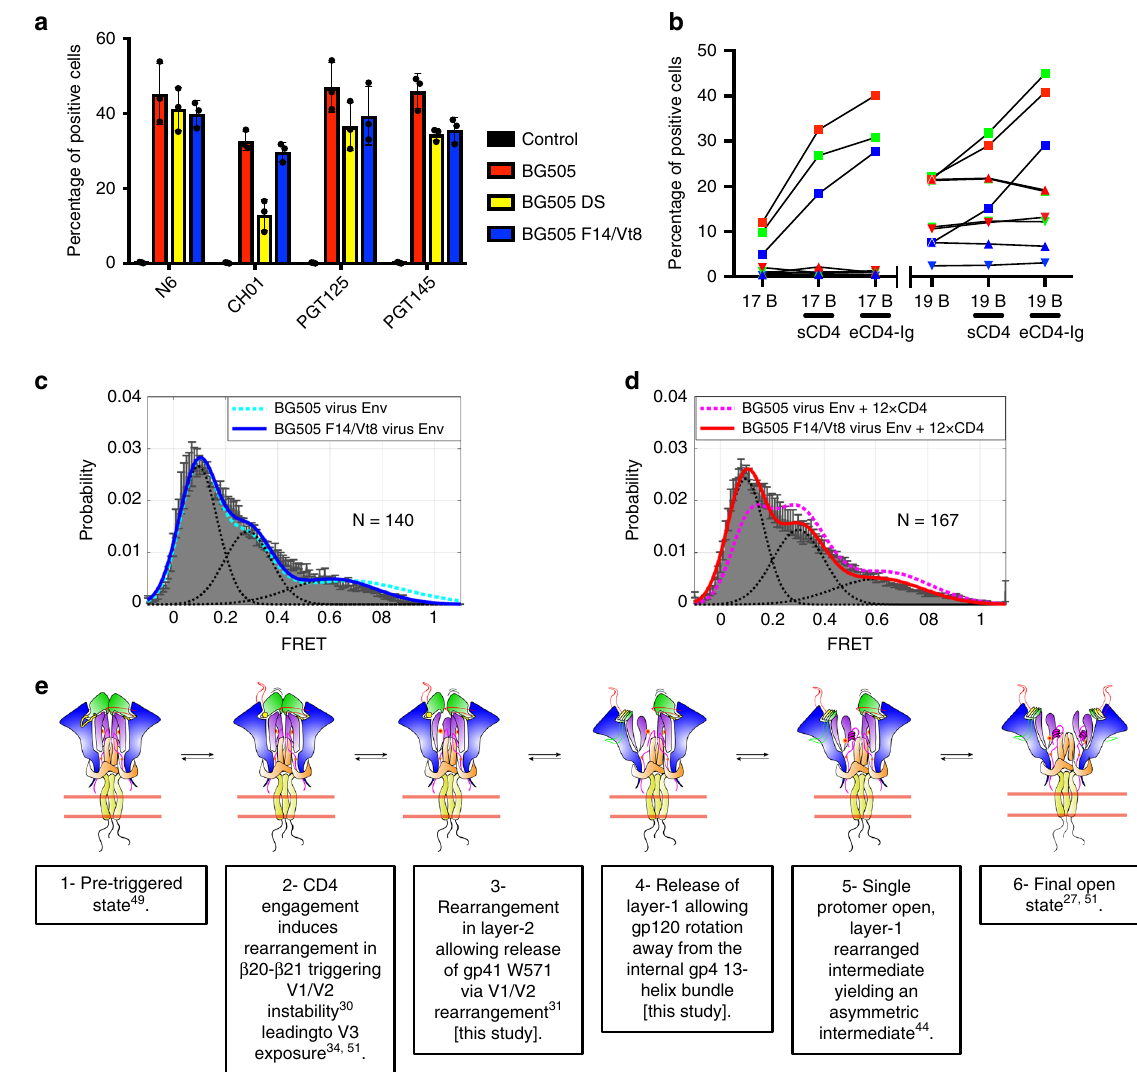
Fig. 6 F14/Vt8 mutations stabilize native, membrane bound Env. a Percentage of cells positive for binding of bnAbs N6, CH01, PGT125, and PGT145 to 293F cell surface expressed BG505, BG505 DS, and BG505 F14/Vt8 trimers. N = 3 independent experiments, error bars represent the standard deviation of the mean. b Chart of the percentage of positive cells from each independent triggering experiment colored according to the fi rst (red), second (green) and third (blue) experiments with BG505 represented as squares, BG505 DS represented as upward oriented triangles, and BG505 F14/Vt8 represented as downward oriented triangles. c Single molecular FRET distribution for BG505 (dashed cyan line) and F14/Vt8 (solid blue line) virus Env. d Single molecular FRET distribution for BG505 (dashed pink line) and F14/Vt8 (solid red line) virus Env in the presence of dodecameric CD4. e Mechanism for transition between a closed state trimer to an open state